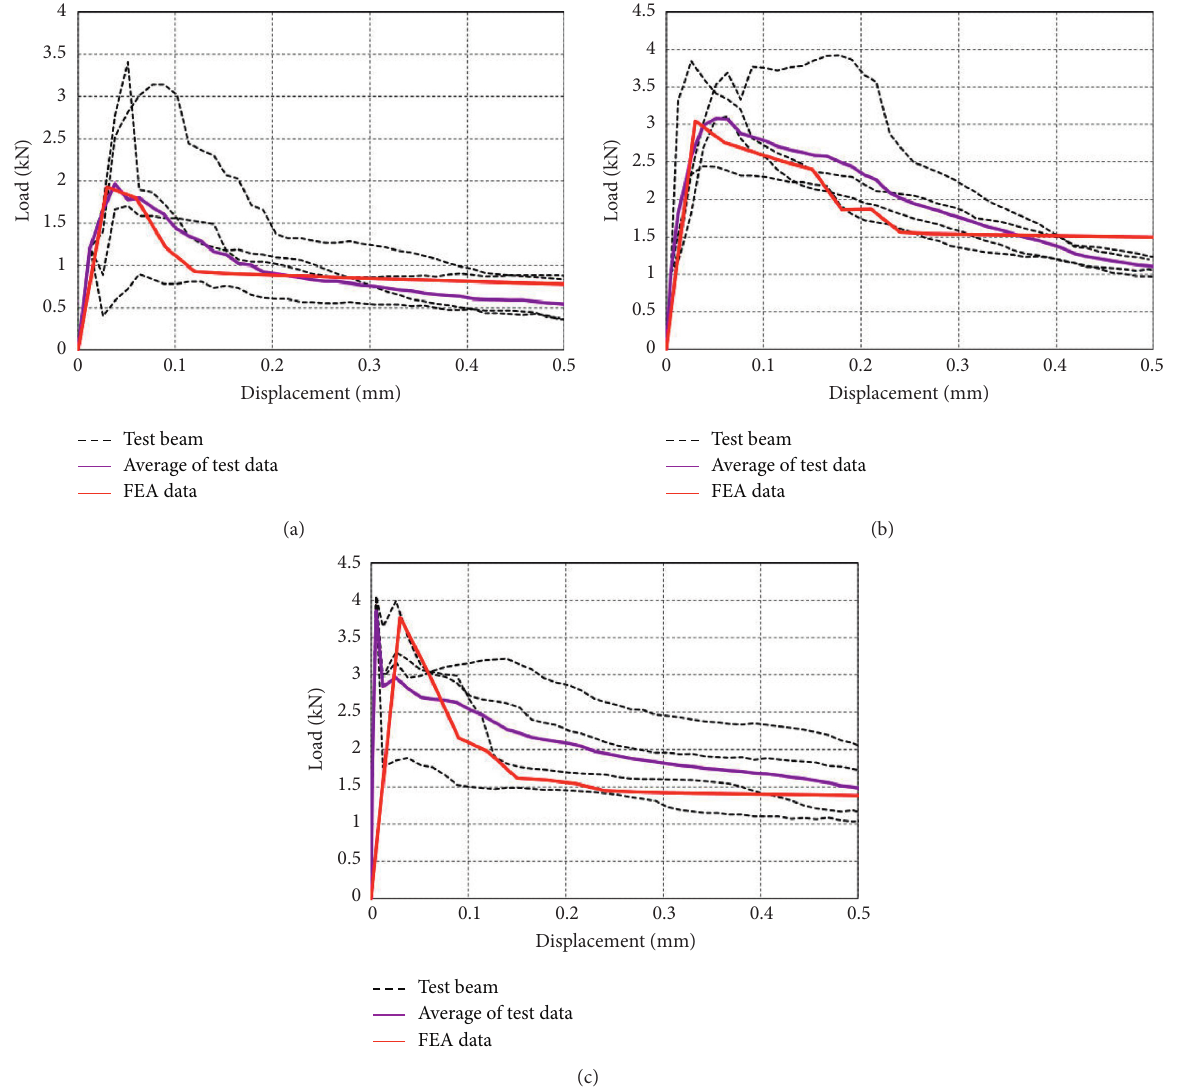
Figure 14: Load-displacement curves of meso-scale numerical tensile analysis and experiment. (a) T_1. (b) T_2. (c) T_3.